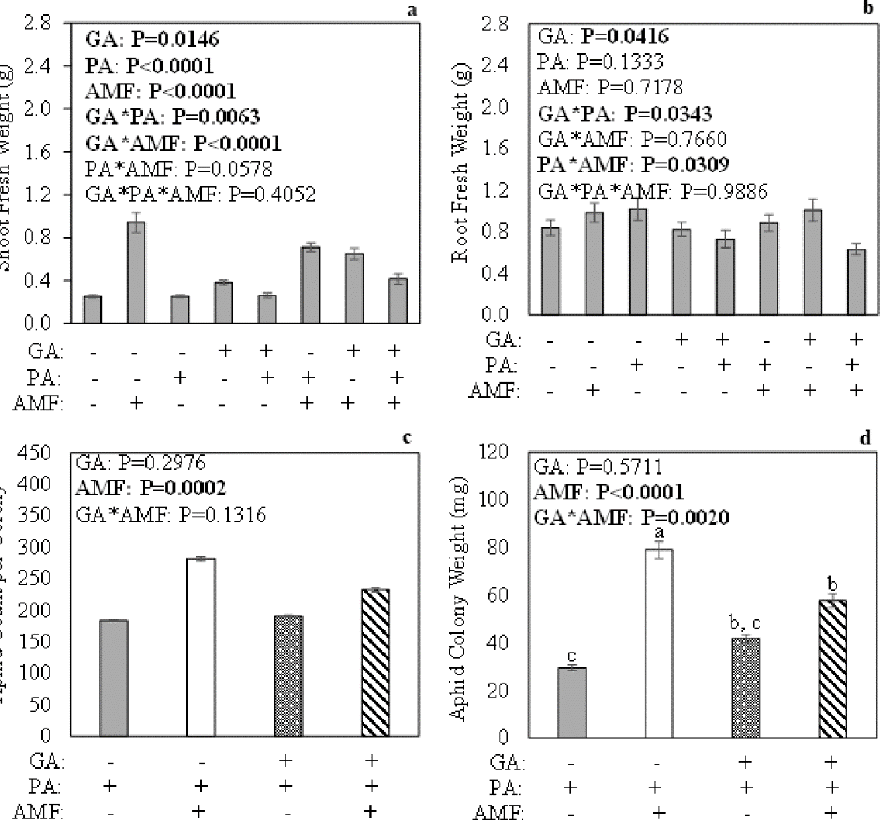
Figure 3. Impact of exogenous gibberellic acid (GA) application, 7 days of pea aphid ( Acyrthosiphon pisum ) (PA) feeding, and AM fungus ( Rhizophagus intraradices ) (AMF) root colonization on Medicago truncatula ( a ) shoot and ( b ) root growth. Impact of exogenous GA and AM fungus root colonization on ( c ) aphid count per colony and ( d ) aphid colony weight. Potted plants were grown in topsoil: sand mix for 49 days. Plants were harvested at 56 days post seed sterilization. Three-factor analysis using gamma distribution ( a ), three-factor ANOVA ( b ), two-factor analysis using Poisson distribution with scaled Pearson χ 2 ( c ), and two-factor ANOVA ( d ) were used. Values represent the mean ± SEM ( n = 6 to 8) per treatment. Different letters represent significant differences among treatment groups using Tukey–Kramer post hoc tests ( p < 0.05).